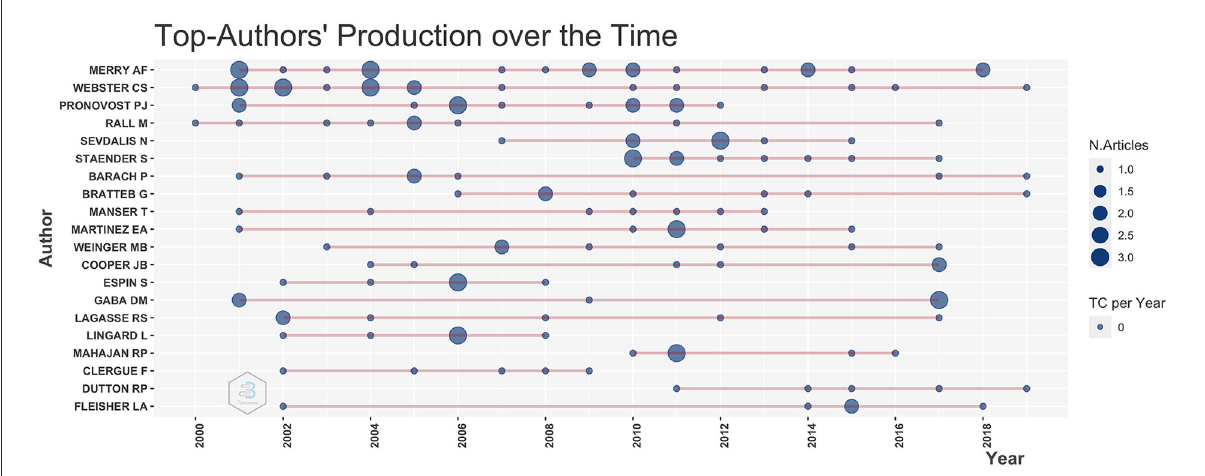
FIGURE3 The 20 top-author’s production over time. The line represents an author’s timeline. The bubble size is proportional to the number of documents published, and the color intensity is proportional to the total citations per year the documents